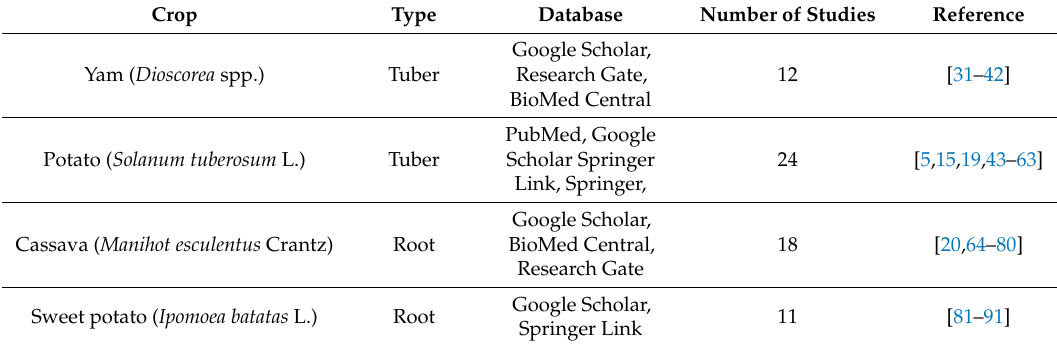
Table 1. Inventory of databases and studies on parentage analysis in selected root and tuber crops. Crop Type Database Number of Studies Reference Google Scholar, Yam ( Dioscorea spp.) Tuber Research Gate, BioMed Central Potato ( Solanum tuberosum L.)